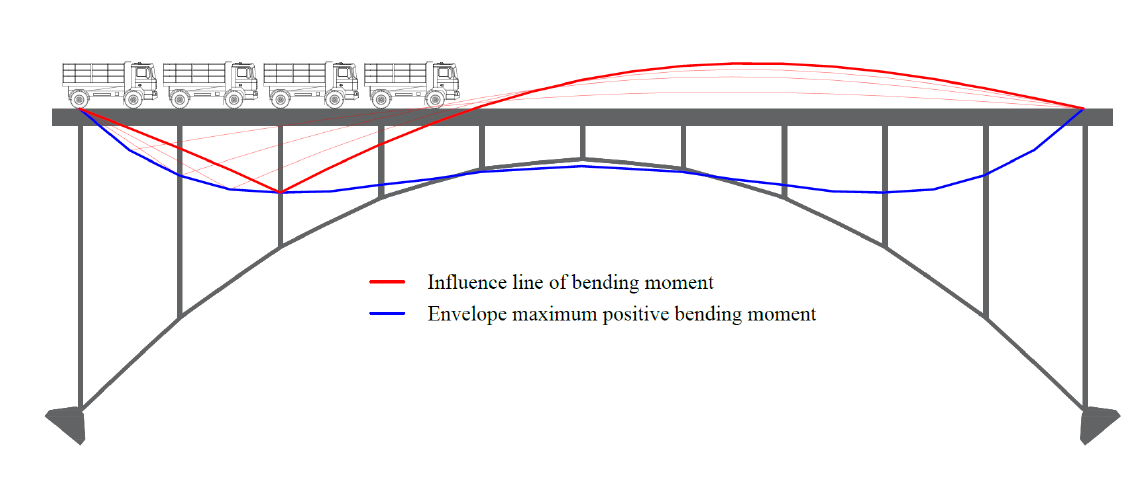
Figure 3. Influence line of bending moment and position of the moving loads able to maximize the positive bending